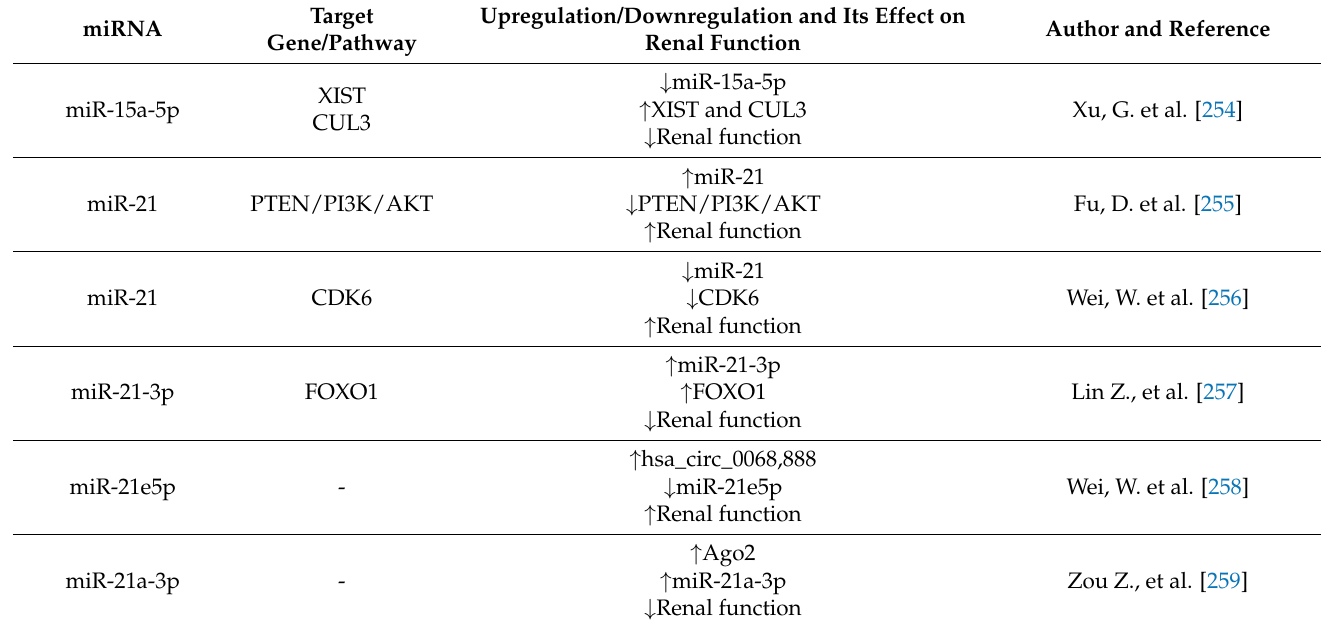
Table 12. miRNAs involved in sepsis-induced kidney dysfunction and their targets. ↑ indicates up regulation, ↓ indicates down